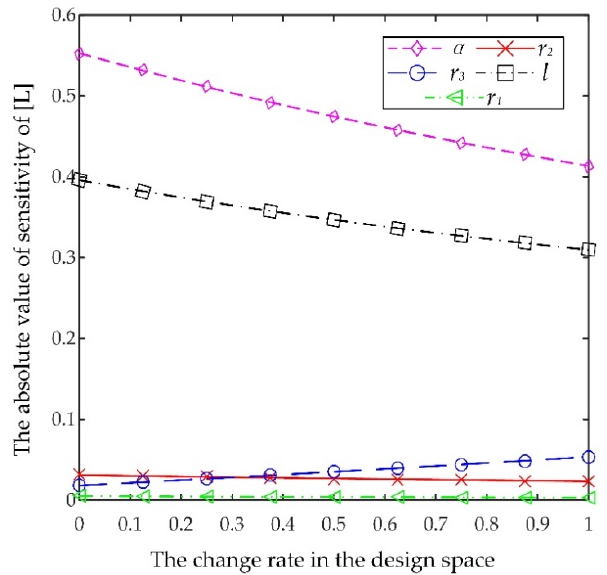
Figure 13. The absolute value of the sensitivities of [ L ] with regard to the change rate of variables in the design space.